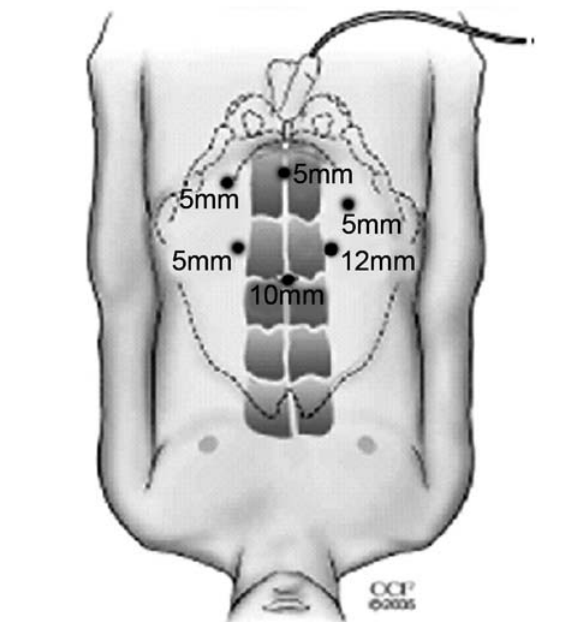
Figure 1 – Port placement during laparoscopic radical pros-